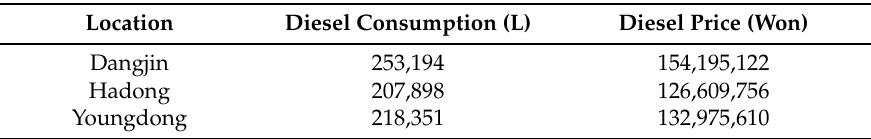
Table 9. Diesel consumption and price in each case.